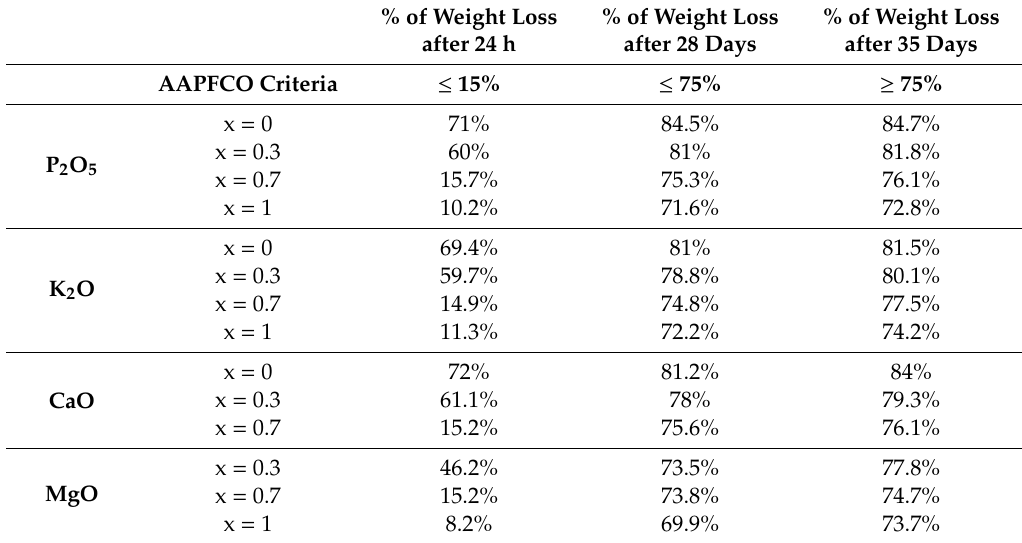
Figure 10. SEM micrographs of ( a ) 3P 2 O 5 -2K 2 O-0.7CaO-0.3MgO and ( b ) 3P 2 O 5 -2K 2 O-0.3CaO-0.7MgO glasses’ surface after 3 days of immersion time at 25 °C. Table 4. % of weight loss of cations, in the form of oxides, after an immersion time of 24 h and 28